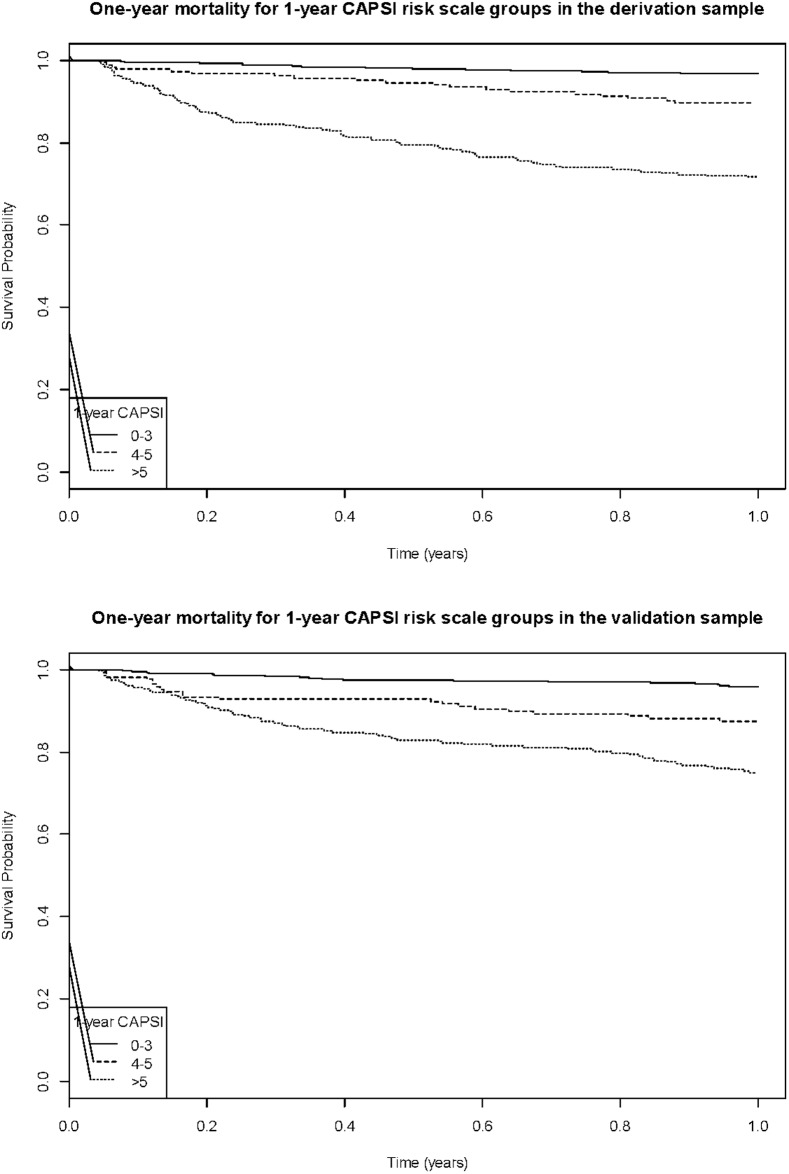
Kaplan-Meier survival curve for the derivation and validation cohorts, stratified by one-year CAPSI risk groups.